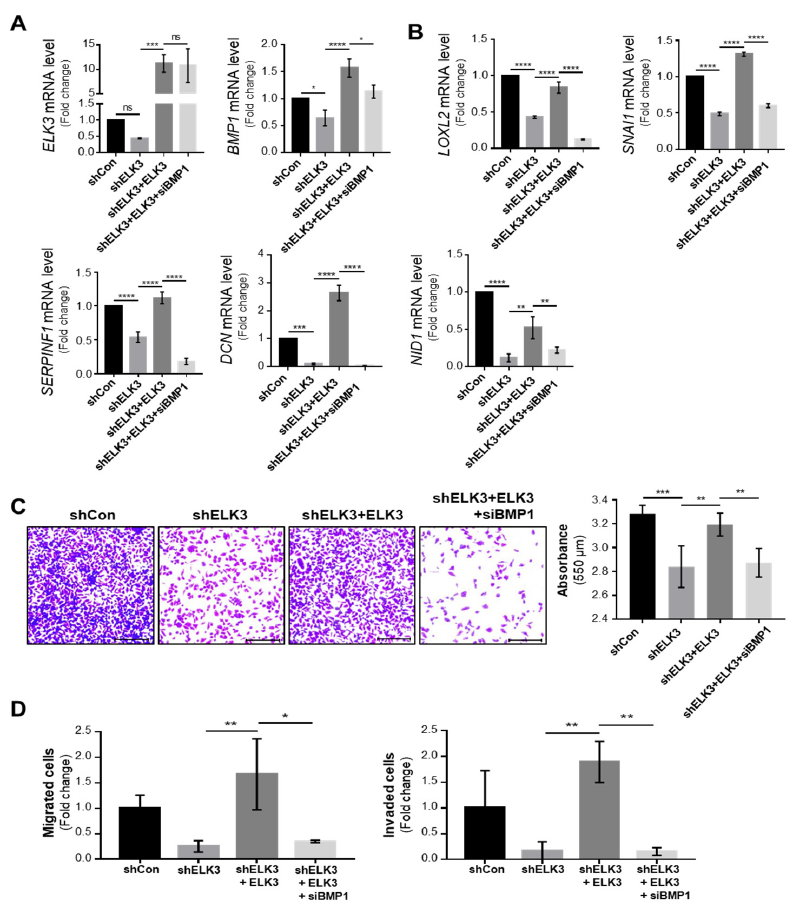
Figure 6. ELK3 regulates gastric cancer cell adhesion through bone morphogenetic protein1 (BMP1)- mediated ECM remodeling. ( A ) Expression of mRNA encoding the ELK3 and BMP1 genes in SNU638 cells transfected with shCon, sh ELK3 , sh ELK3 plus pLenti-cMyc-DDK- ELK3 plasmid DNA ( ELK3 rescue), or ELK3 rescue plus si BMP1 . Error bars represent the standard deviation; * p < 0.05, *** p < 0.001, and **** p < 0.0001 (one-way ANOVA). ( B ) Expression of mRNA encoding the LOXL2, SNAI1, SERPINF1, DCN, and NID1 genes in SNU638 cells transfected with shCon, sh ELK3 , ELK3 rescue, or ELK3 rescue plus si BMP1 . Error bars represent the standard deviation; ** p < 0.01, *** p < 0.001, and **** p < 0.0001 (one-way ANOVA). ( C ) Representative images showing cell adhesion of SNU638 cells transfected with shCon, sh ELK3 , ELK3 rescue, or ELK3 rescue plus si BMP1 . Scale bar, 200 μ m. Bar graphs indicate the absorbance value of adherent cells. Error bars represent the standard deviation; ** p < 0.01 and *** p < 0.001 (one-way ANOVA). ( D ) Representative images showing cell migration and invasion of SNU638 cells transfected shCon, sh ELK3 , ELK3 rescue, or ELK3 rescue plus si BMP1 . Scale bar, 200 μ m. Bar graphs indicate the number of migrated cells. Error bars represent the standard deviation; * p < 0.05 and ** p < 0.01 (one-way ANOVA). ELK3, ETS transcription factor ELK3; sh, short hairpin RNA; Con, control.